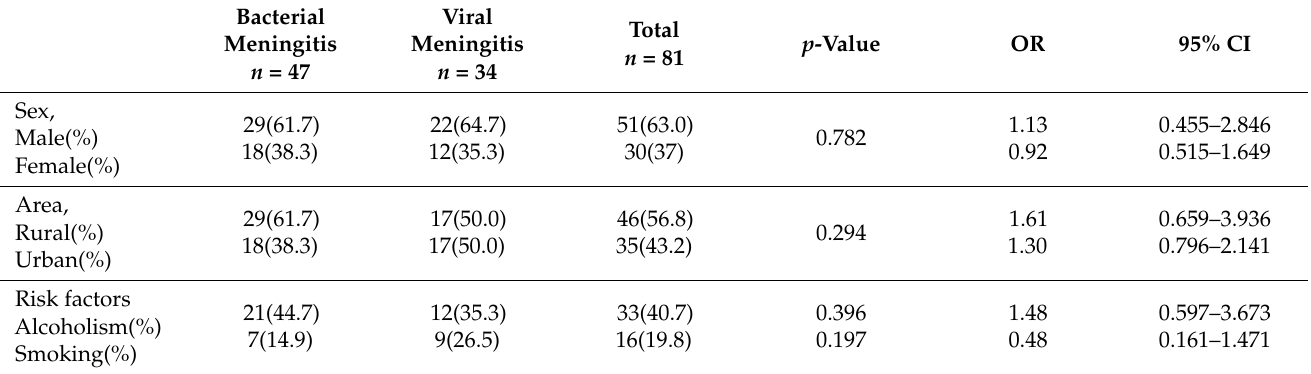
Table 2. Risk factors for bacterial meningitis.